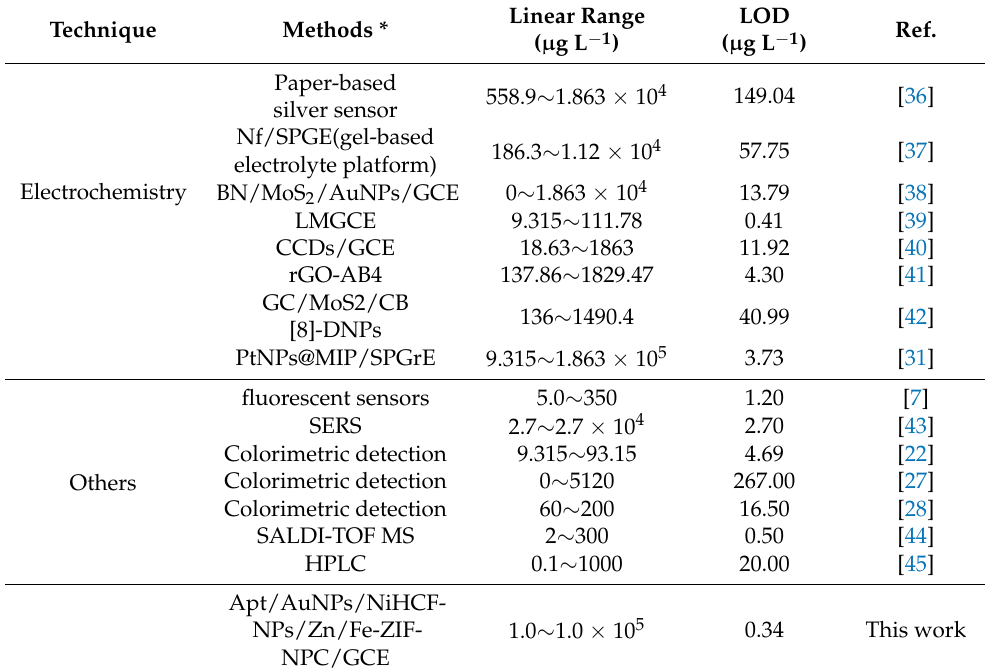
Table 1. Comparison of the proposed aptasensor with other PQ detection methods.